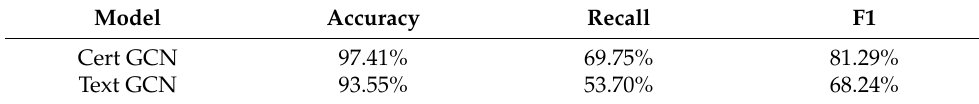
Table 3. Evaluation of model results of malicious certificate detection by Cert GCN and Text GCN.